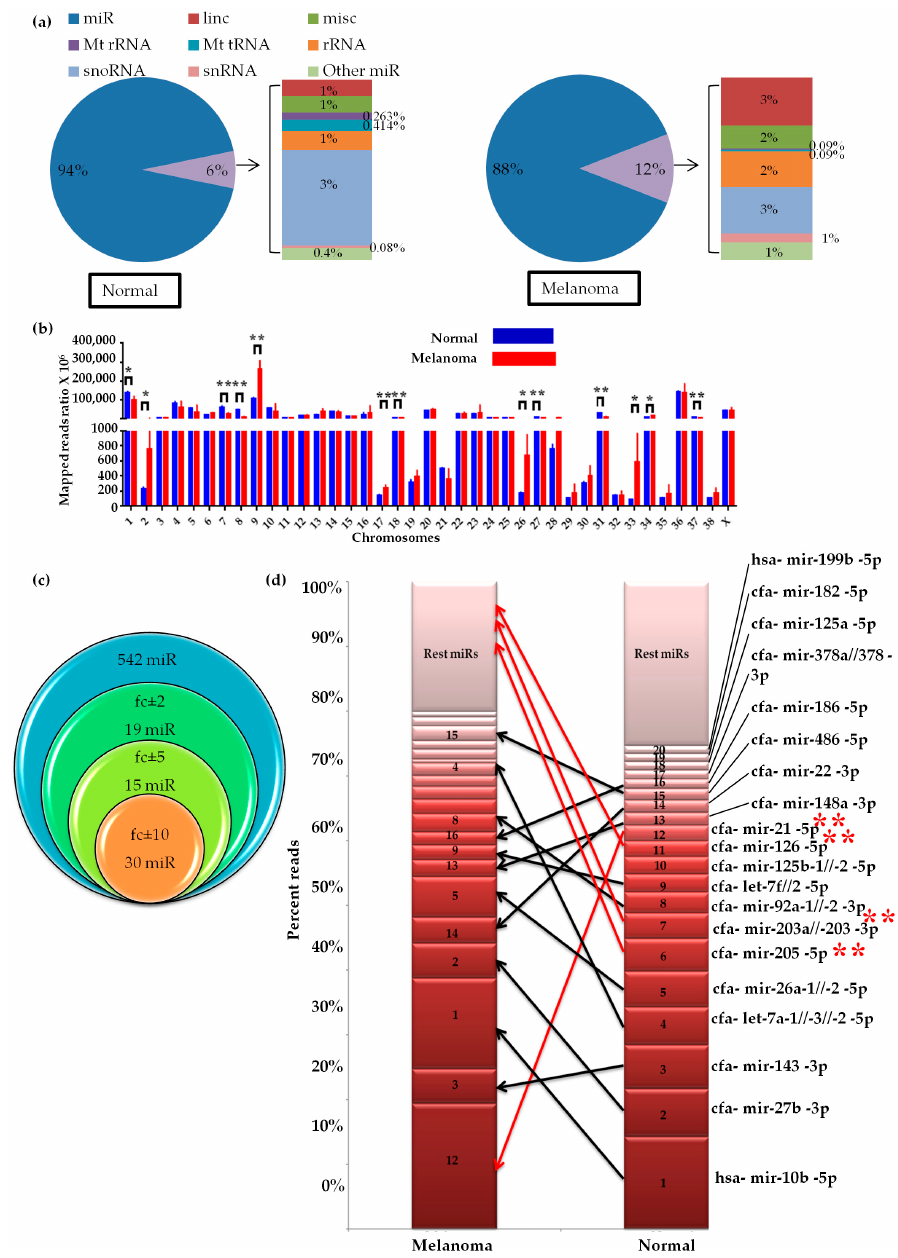
Figure 1. Profile of small RNA reads in canine oral melanoma by next-generation sequencing: ( a ) Percentages of the clean reads annotated under the different small RNA categories. Normal ( n = 3), Melanoma ( n = 8), ( b ) The miRNA reads were mapped to the canine genome (Canfam3.1) and the mapped reads ratio distributed in each chromosome was analyzed. Multiple t-test (many t-tests at once-one per row), * P < 0.05, ** P < 0.01, ( c ) Venn diagram showing the total numbers of identified and differentially expressed miRNAs in melanoma. First Venn (blue) indicates the total number of miRNAs identified in both groups. Other three Venn indicates the number of differentially expressed miRNAs (up (+) and down-regulated ( − )). fc, fold change, ( d ) Top 20 highly expressed miRNAs in the normal and melanoma. Twelve miRNAs were common between the groups and rests eight were left blank in melanoma. In the bar graph, the number in each cell represents the rank of the miRNA with respect to the normal group. Arrows represent the changed position of miRNAs in melanoma group, Red arrows indicate the positions of significant deferentially expressed miRs. miRNA/s (miR/s), * statistically significant differentially expressed miRs between normal and melanoma.